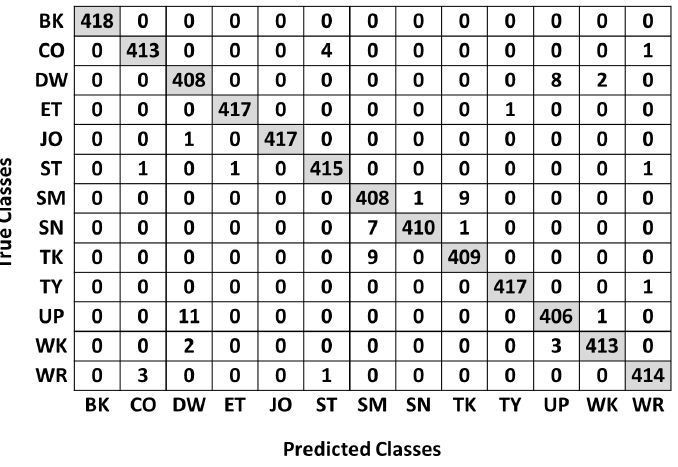
Figure 5. Confusion matrix for the RF classifier under subject-dependent evaluation criteria.